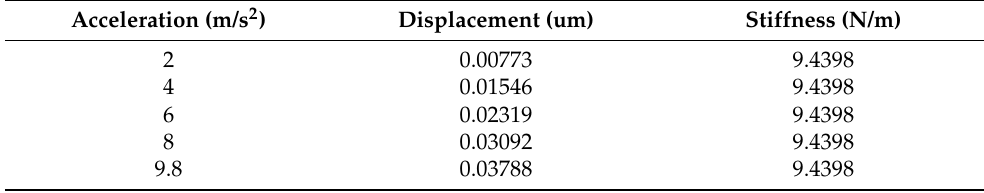
Table 1. Static force analysis (single-stage beam).